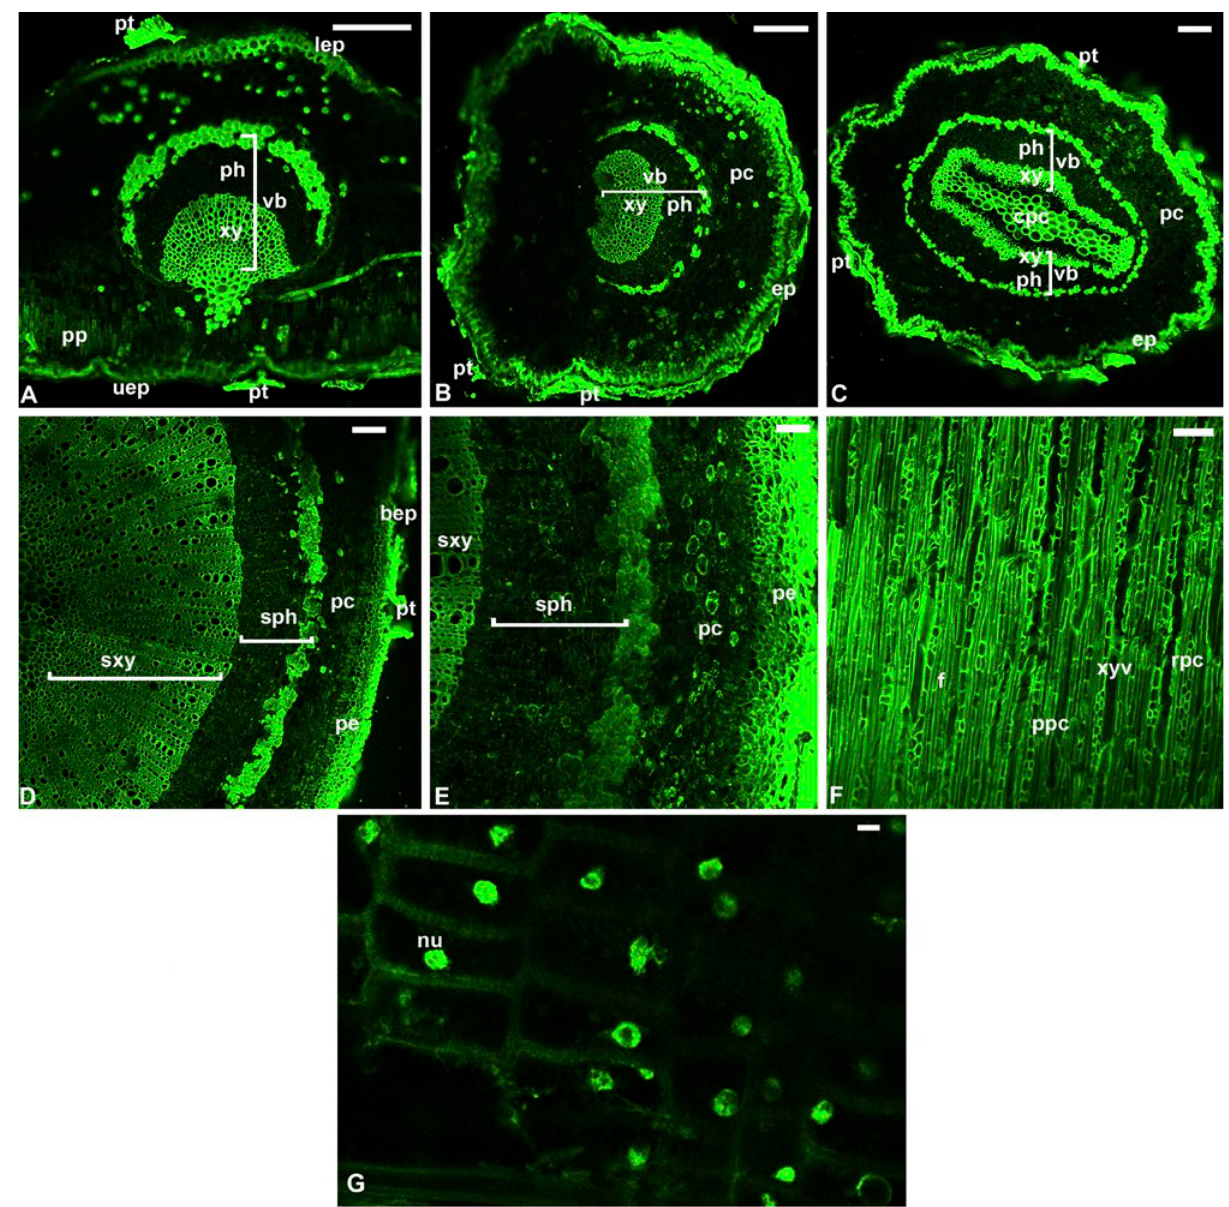
Figure 1. Confocal microscope images of transverse sections of leaf (A), petiole (B), peduncle of the fruit (C), two-year-old twig (D), five-year-old twig (E), and longitudinal tangential section of 5-year-old twig (F) excised from a healthy olive cv. Ogliarola salentina tree sprayed with a safranin-O/Dentamet® mixture. High magnification of the ray parenchyma cells (G). Upper epidermis (uep), peltate trichome (pt), palisade parenchyma (pp), vascular bundle (vb) with xylem (xy) and phloem (ph), lower epidermis (lep), epidermis (ep), parenchyma cells (pc), central parenchyma cells (cpc), secondary xy- lem (sxy), secondary phloem (sph), periderm (pe), broken epidermis (bep), xylem vessel (xyv), paratracheal parenchyma cells (ppc), fibers (f), ray parenchyma cells (rpc), nucleus (nu). Scale bars = 100 μm (A-F) and 5 μm